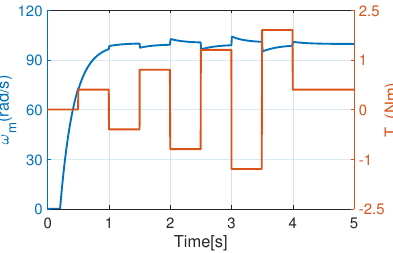
Figure 3. Dynamic behavior with applied torque.